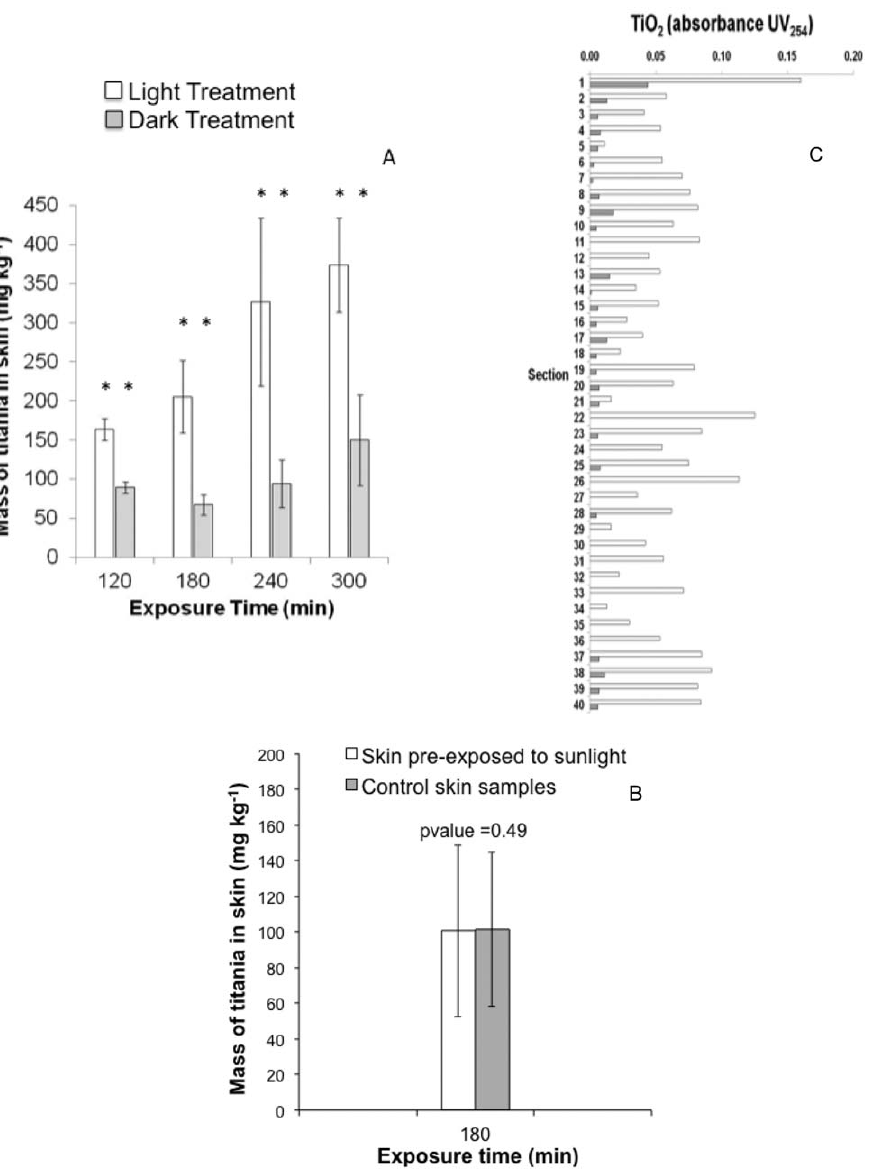
Figure 3. Mass of titanium in sunlight exposed skin grafts increasing with exposure to sunlight, indicating higher accumulation of TiO 2 NPs within the skin (Panel A). The mass of titanium in the dark treatments is much lower compared to the mass found in the irradiated treatment, and does not increase significantly with time. Panel B: Skin pre-exposed to 180 min of sunlight and then subjected to 180 min of sunlight and TiO 2 doesn’t accumulate more TiO 2 than skin not pre-exposed to sunlight. Control samples in Panel B were skin samples not pre-exposed to sunlight but subjected to the TiO 2 dosing. Skin sections show that little to no titanium is found in the dark treatment, while it is found in all 40 sections for the irradiated sample (panel C). Stars indicate statistical significance with a p-value # 0.05. Molar exctinction coefficient was 2,169 cm 2 1 M 2 1